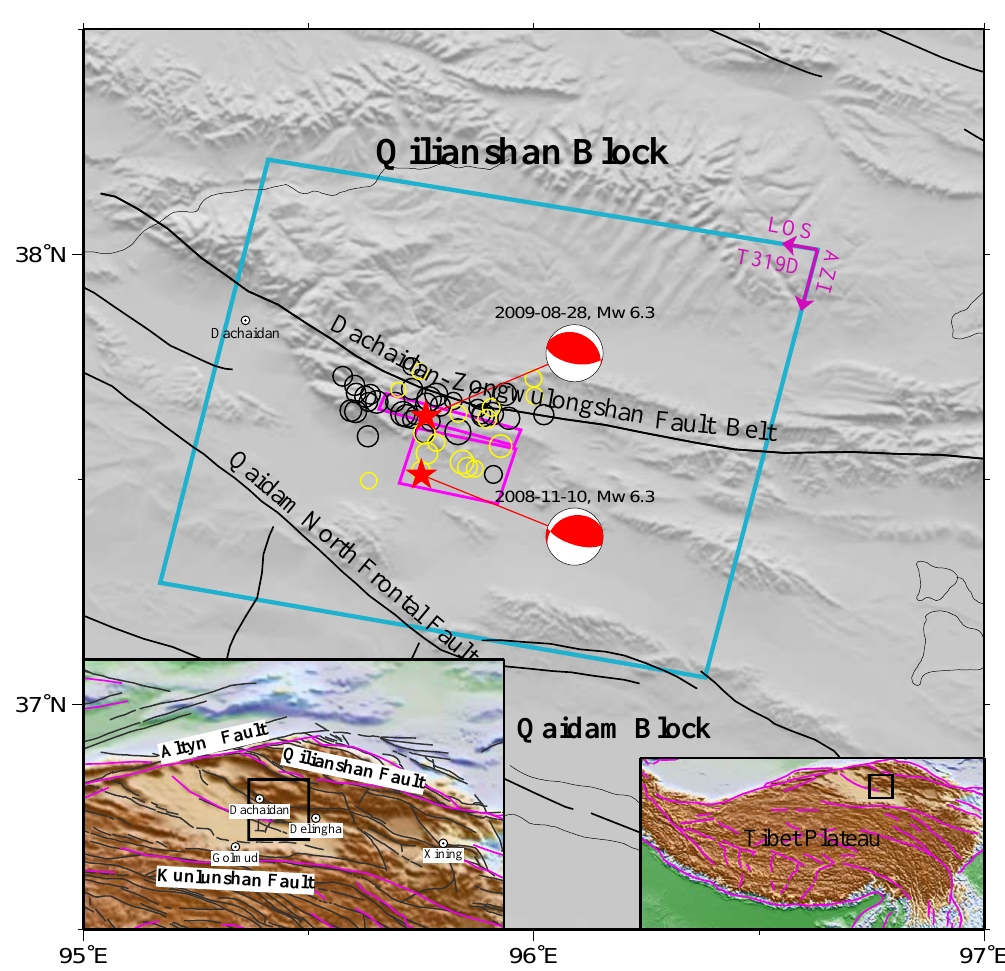
Figure 1. Tectonics associated with the 2009 Mw 6.3 DCD earthquake. The bottom-left and bottom-right insets show the location of the main figure, respectively. The light blue rectangle is the spatial extent of the Envisat Advanced Synthetic Aperture Radar (ASAR) descending Track 319 images, with AZI and LOS referring to satellite azimuth and look directions. The focal mechanisms of the 2008 and 2009 events are from United States Geological Survey (USGS) [4]. The two purple rectangles are the surface projections of the main fault rupturing zones during the 2008 and 2009 events [3,21]. The black and yellow hollow circles are the aftershocks of the 2008 and 2009 events, respectively [4]. The purple and black lines are the active faults from Peltzer and Saucier [24] and Deng et al. [5],